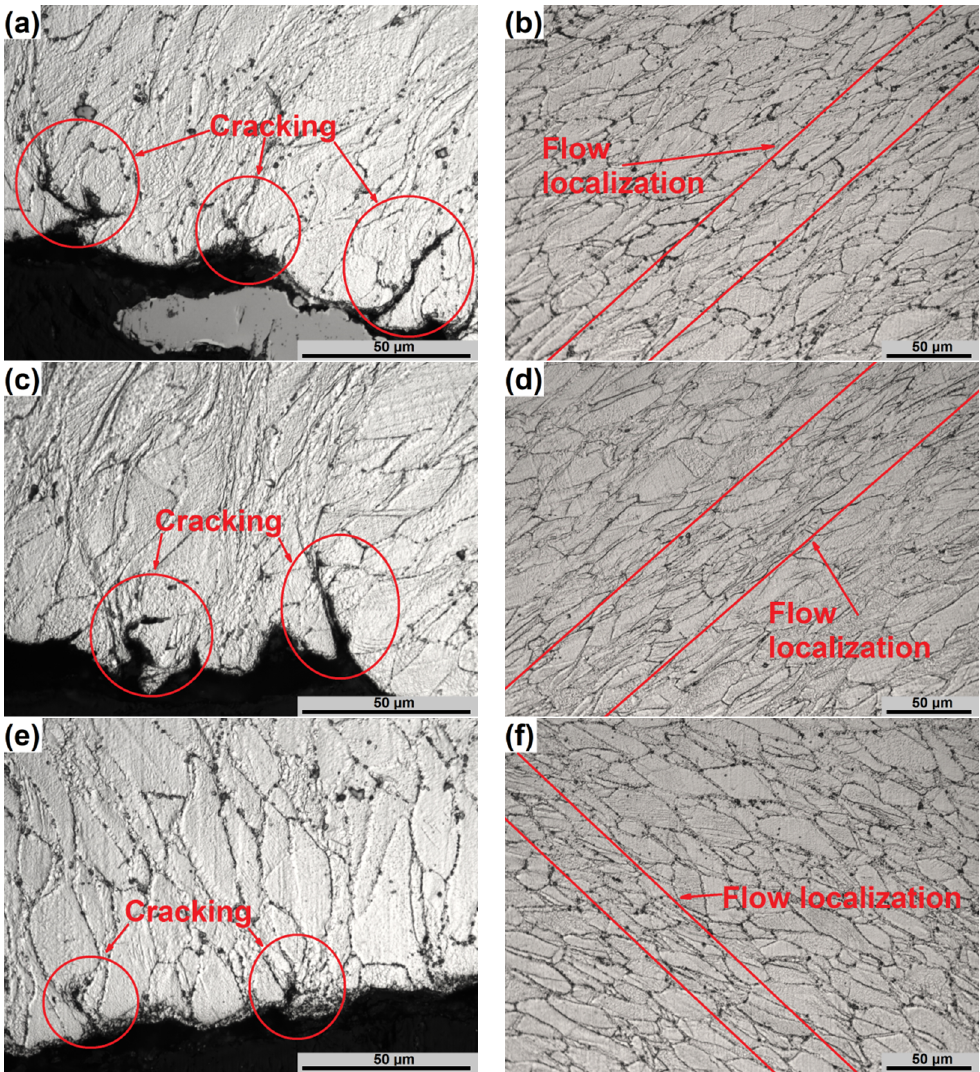
Figure 6. Typical microstructures of the specimens deformed at the temperatures and strain rates of ( a , b ) 900 ◦ C / 0.1 s − 1 , ( c , d ) 900 ◦ C / 1 s − 1 , ( e , f ) 1000 ◦ C / 0.1 s − 1 at instability